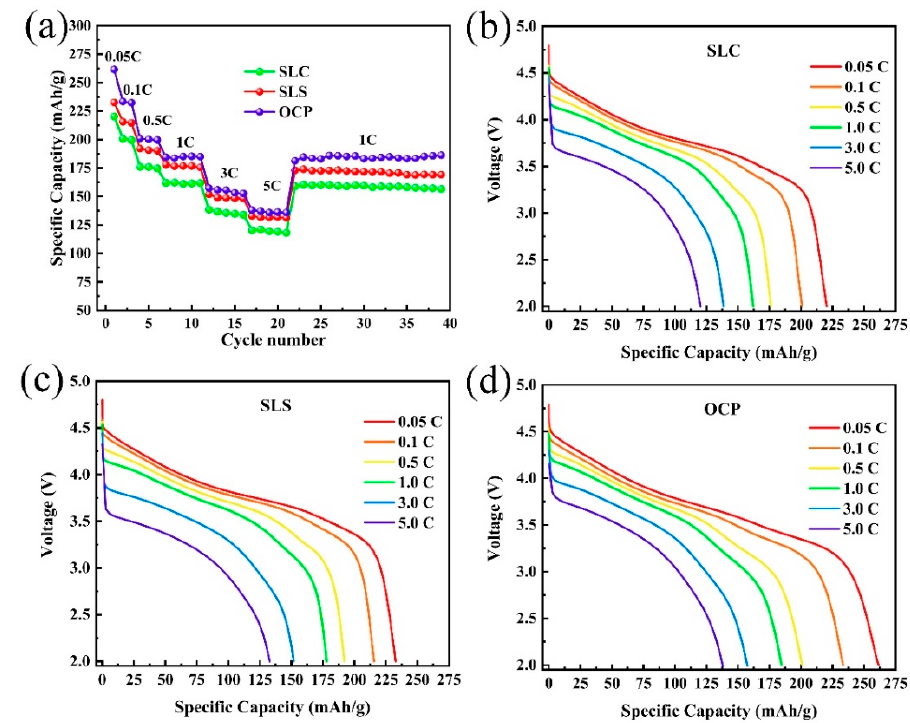
Figure 7. Rate performance of LL-811 samples prepared by di ff erent methods: ( a ) rate capacity, ( b – d ) discharge curves at di ff erent rates.